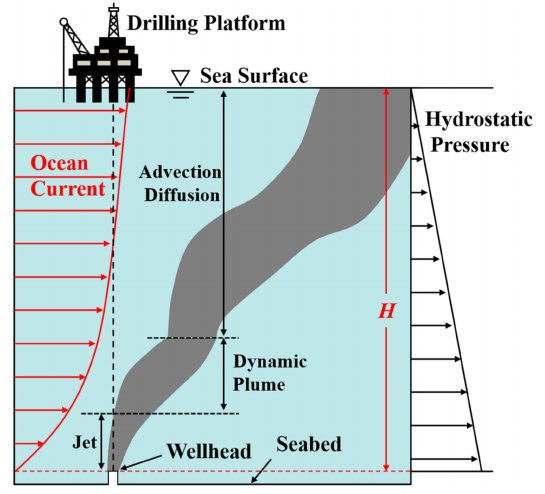
Figure 1. Underwater oil spill